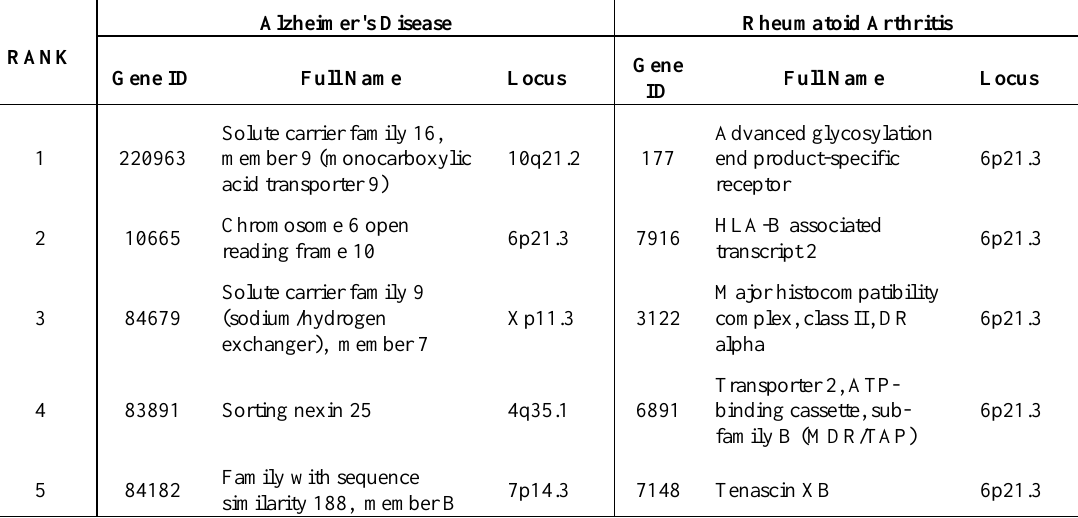
Table 10. Top 5 genes with the lowest combined p -values. Given the p-value threshold of 0.05; 2,076 genes are listed as significant for AD and 69 of them are listed as significant for